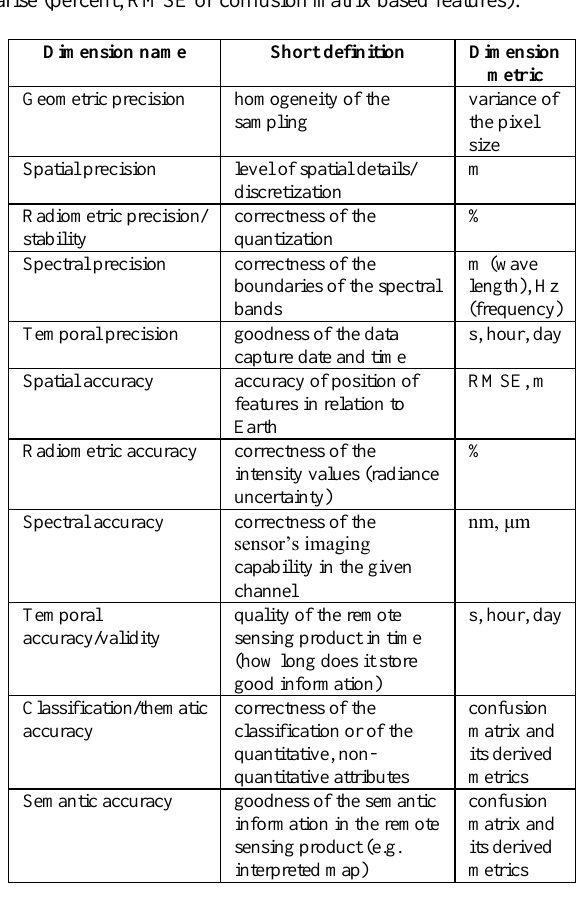
Table 4. Accuracy dimension cluster